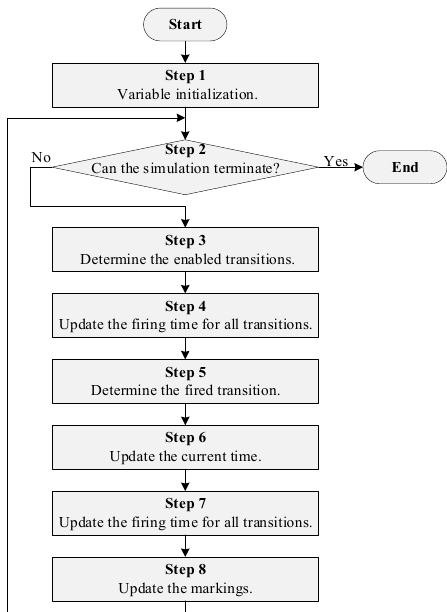
Figure 5. The discrete-event simulation for maintenance time.